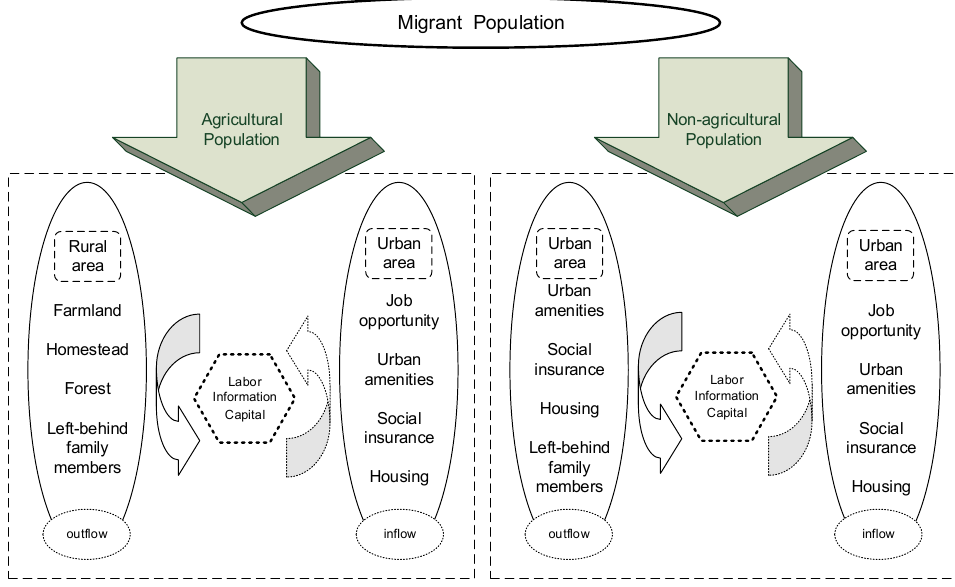
Figure 1. Conceptual